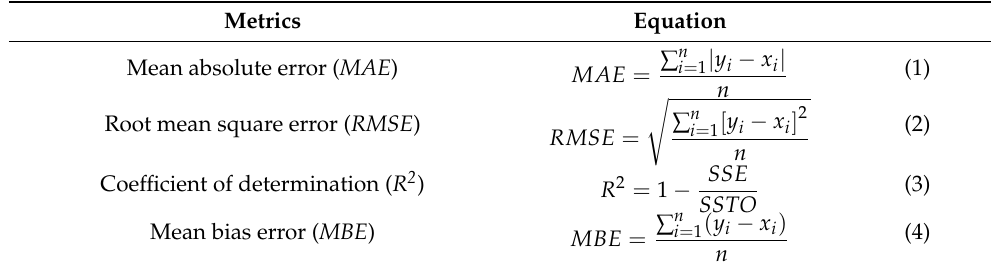
Table 4. Measurements to assess model